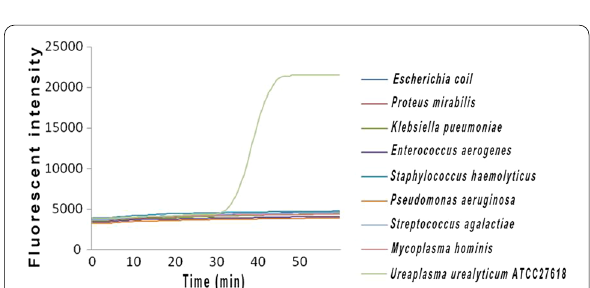
Fig. 2 The specificity of real‑time fluorescence